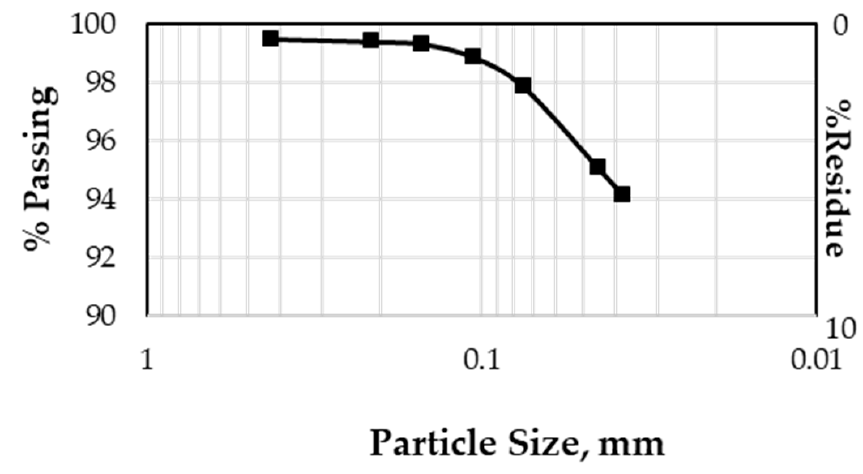
Figure 1. Particle size distribution (PSD) of nickel laterite mine waste (NMW).